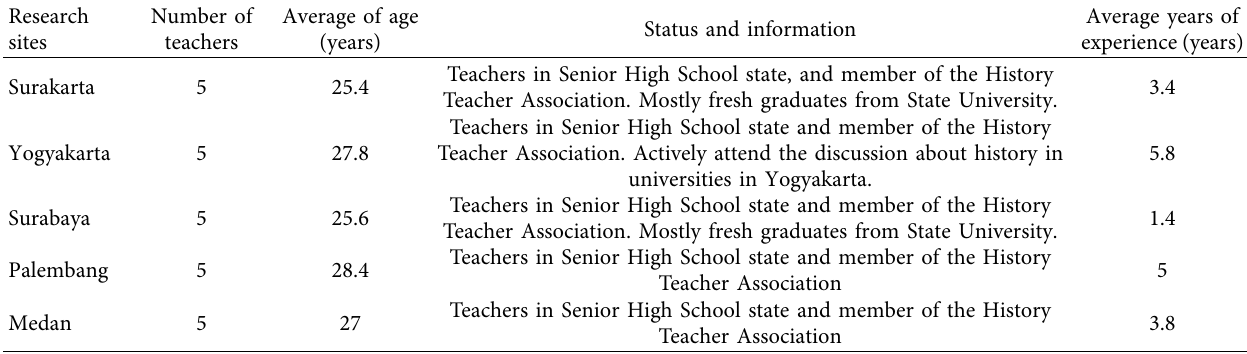
Table 1: Profile of history